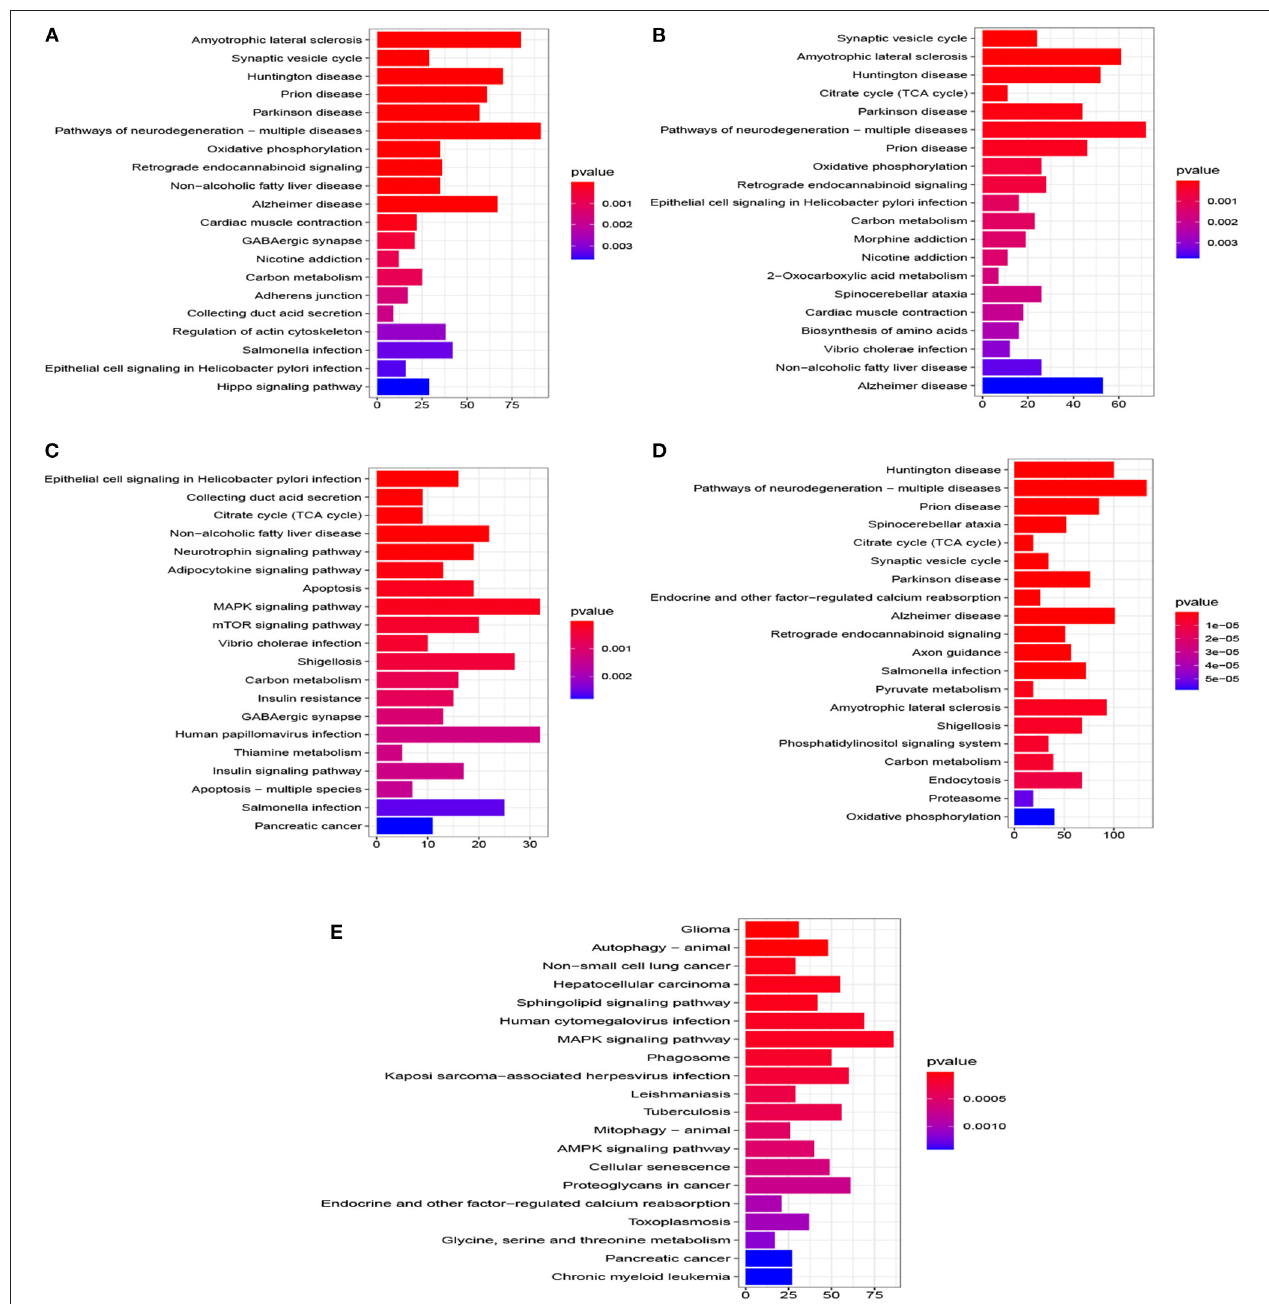
FIGURE 5 | Top 20 pathway of KEGG for five datasets ( P < 0.005). (A) EC, (B) HP, (C) FC, (D) TC, and (E) ADNI.